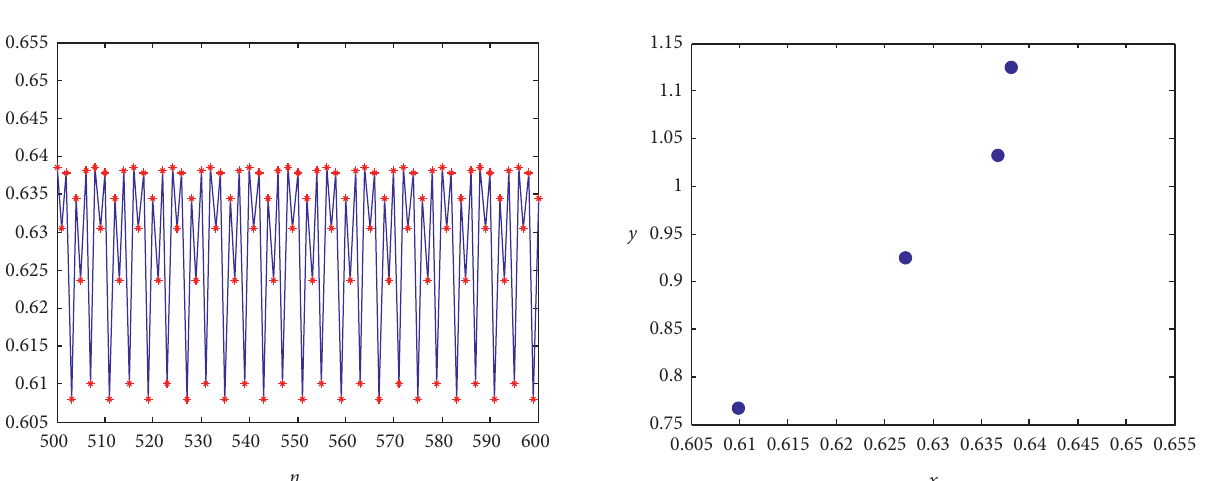
Figure 25: x - y phase diagram which denotes that the system is 4-fold periodic when c � 0.08.